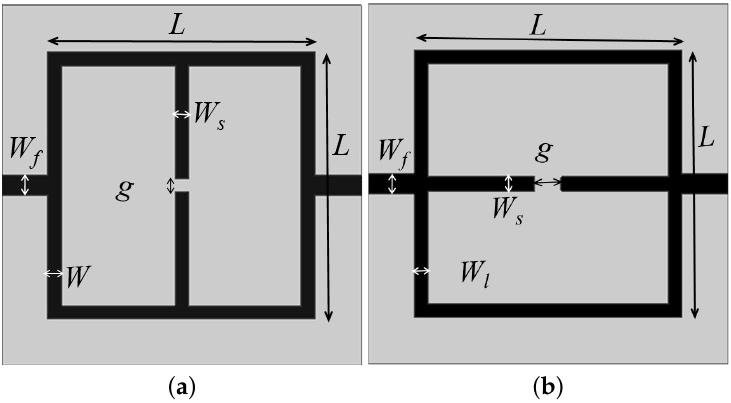
Figure 3. Geometry of the first two sensors realized with closed loop resonators and stubs loading: ( a ) perpendicular; ( b ) parallel to microstrip feeding